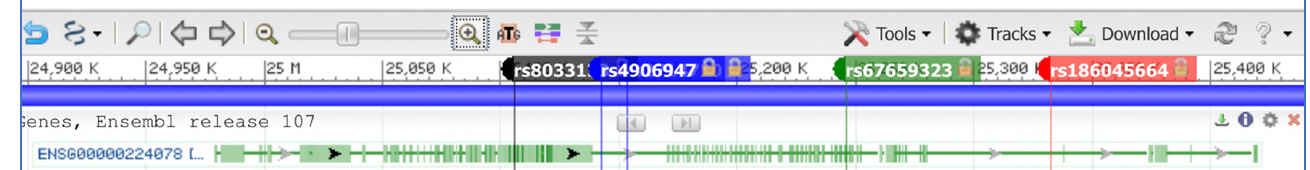
Figure 7. Localization of SNVs within the SNHG14 host gene locus. The e!Ensembl gene name for SNHG14 is shown (ENSG00000224078). Five SNVs are shown (rs2714720 is 5 ′ to rs4906947 with the tag name hidden).